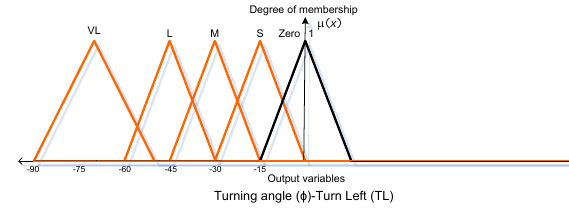
Fig. 10. The membership functions for output variables “turn left”